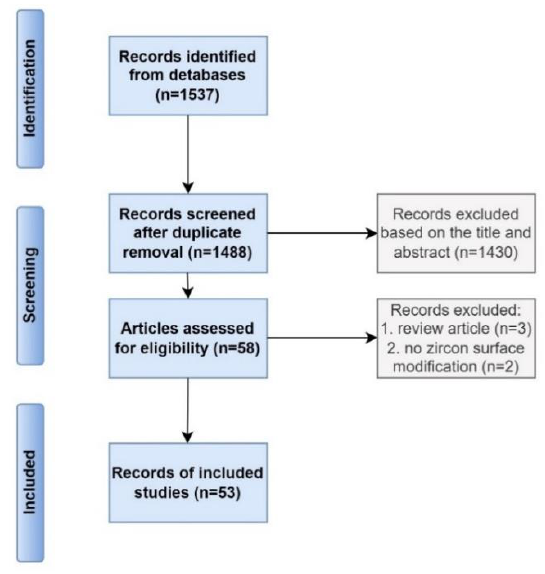
Figure 1. Flow diagram of review protocol.